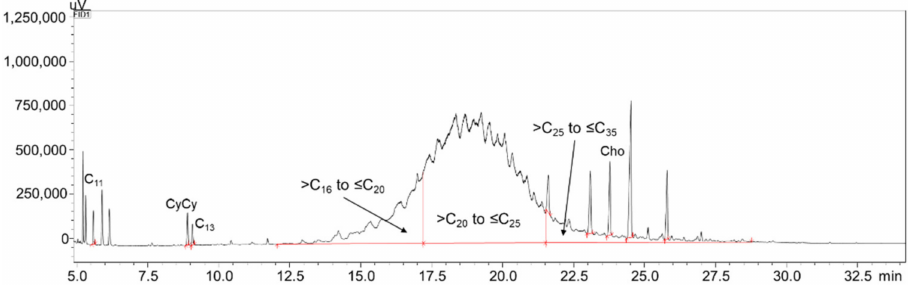
Figure 1. LC-GC expansion of the MOSH fraction of sample 2, along with IS and C-fractions.